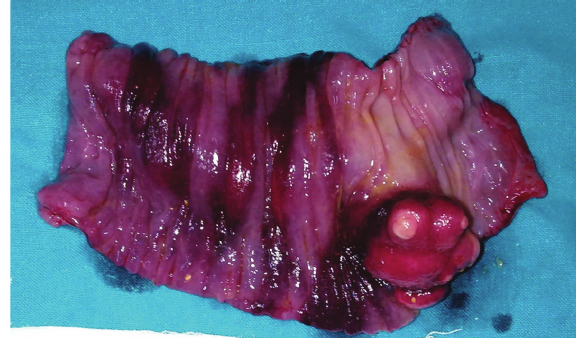
Figure 3: Specimen of resected terminal ileum cut section showing lobulated intraluminal growth.